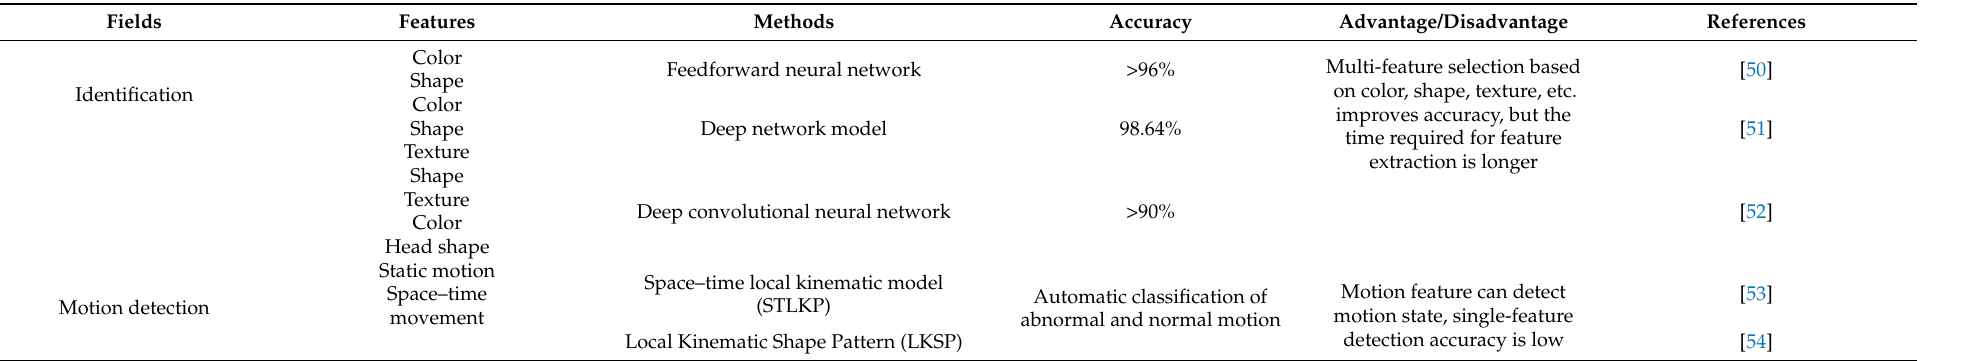
Table 2. The application of feature extraction in aquaculture fish identification and behavior